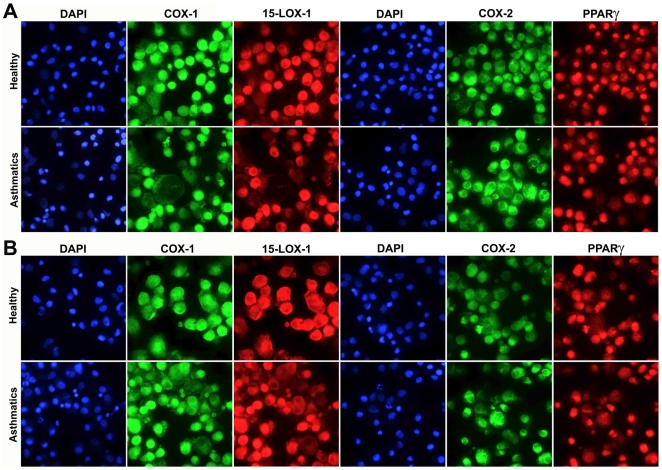
Fluorescent immunocytochemistry was performed on cytospun BAL-cells using monoclonal antibodies against COX-1, COX-2, 15-LOX-1 and PPARγ coupled with secondary antibodies labeled with fluorescent dyes Alexa488 (green) and Cy5 (red).Nuclear counter-staining was performed using DAPI (blue). Representative micrographs from a healthy and an asthmatic individual are shown for both the control air (A) and subway air (B) exposures. Semi-quantitative evaluation of staining intensities was performed using ImageJ software [24].